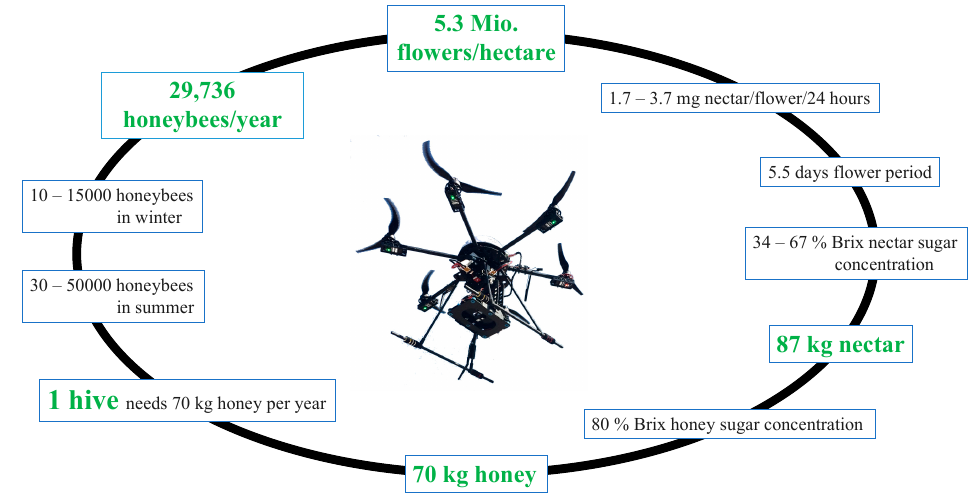
Figure 6. Flow chart connecting flowers, nectar, and honeybees per hectare. The green-text is the data calculated by using Model (2), the black text is data from the literature [2,84–87]. Honey analysis by refractometer shows 81% Brix honey sugar concentration and 16% water. In the laboratory, the microscopic investigation of pollen (DIN 10760 (a) (A)) [88] (535 and 551 pollen analyzed) reveals that the honey of both beekeepers can be considered R. pseudoacacia (acacia honey).